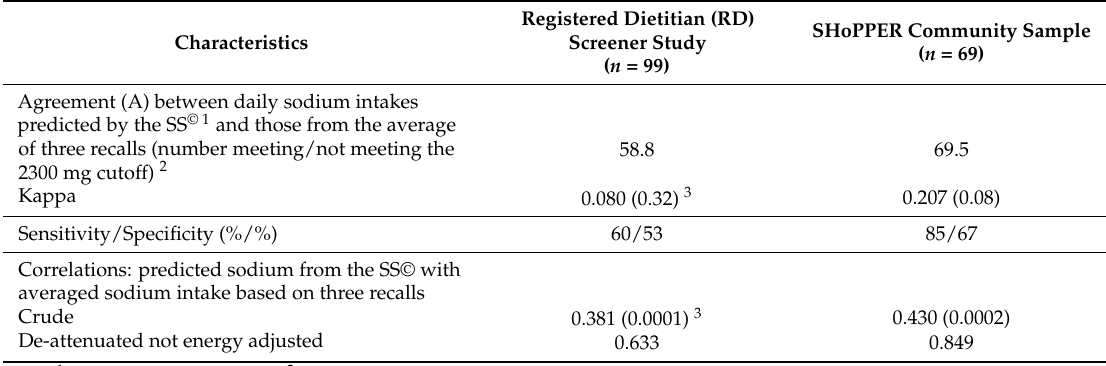
Table 2. Agreement, sensitivity, specificity, and concordance between methods used to estimate dietary sodium